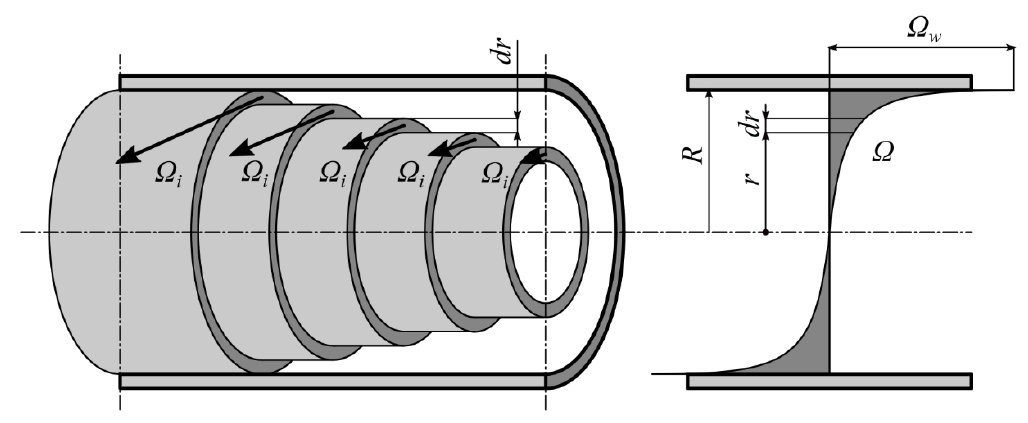
Figure 4. A vorticity distribution over the pipe cross-section.